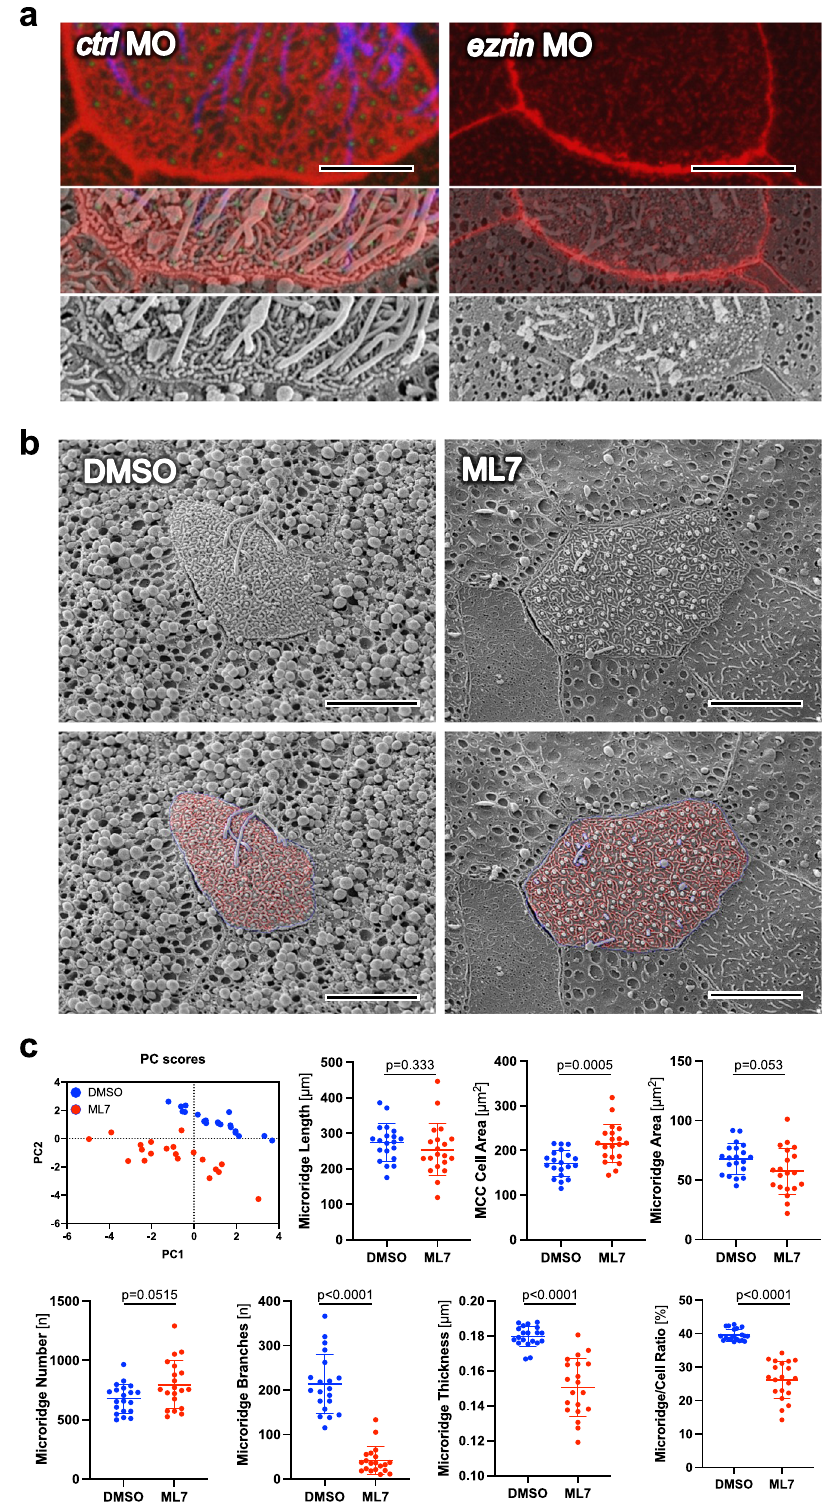
Fig. 6 Ezrin and Nonmuscle Myosin II are essential for microridge formation. a While the actin cytoskeleton, labeled by phalloidin (red) co-localizes with microridges visualized by scanning electron microscopy (SEM), both actin cytoskeleton and microridge architecture are completely disrupted after knockdown of ezrin (scale bar ctl MO, 4.5 µ m; scale bar ezrin MO, 9 µ m). b Inhibition of Myosin Light Chain Kinase (MLCK) by ML7 disrupted microridge development (scale bars, 9 µ m). c Twenty cells obtained from 2 DMSO- or ML7 (40 µ M) treated Xenopus embryos were visualized by SEM and analyzed by U-net 41 . Principal component analysis (PC scores) separated the DMSO- and ML7-treated MCCs based on seven different parameters (microridge length, MCC cell area, microridge area, microridge number, branches, thickness, and microridge to cell ratio). While the surface area of MCCs treated with ML7 was increased, the number of microridges, the number of branch points and the microridge thickness was signi fi cantly reduced, decreasing the ratio between cell surface area and the area occupied by microridges (mean; Mann – Whitney U test). Images were obtained at stage 29-30. Source data are provided as a Source Data fi le. NATURE COMMUNICATIONS| (2022) 13:2056